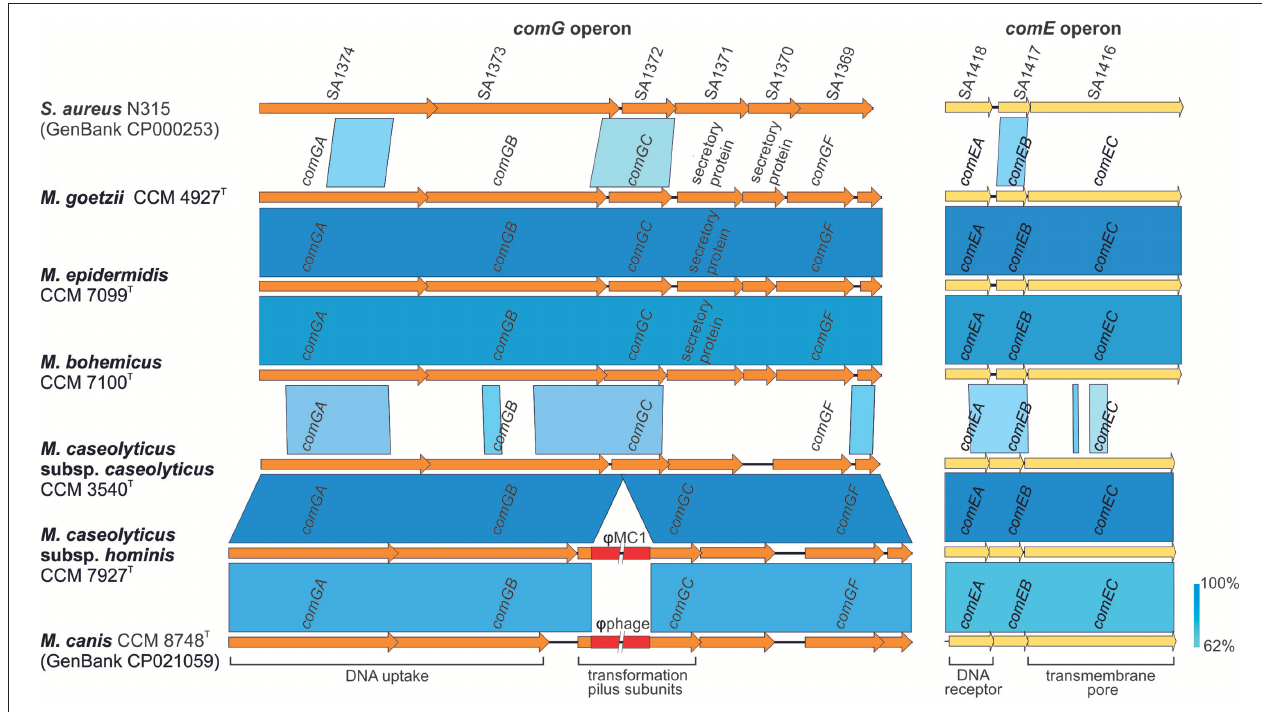
FIGURE 4 | Genetic structure of com operon in human macrococci. The picture shows a comparison of the comG and comE operons, which might be functional in macrococcal strains CCM 4927 T , CCM 7099 T , and CCM 7100 T . The genes are annotated according to Fagerlund et al. (2014); ComGA is a traffic ATPase, ComGB a polytopic membrane protein and ComGC major component of a pilus ensuring the competence of bacterial cells during transformation. Genes comGD , comGE, and comGF encodes minor pilin structure. ComEA is a membrane DNA receptor, ComEB a late competence protein, and ComEC a channel for DNA